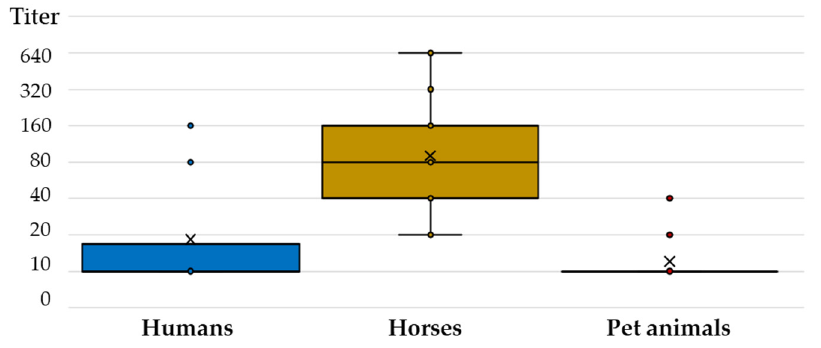
Figure 3. Geographic distribution of Tahyna virus seropositive humans, horses, and pet animals. (symbol size represents the number of cases) Comparing the TAHV NT antibody titers, a substantially higher titer was observed in horses (median 80, IQR = 40–160) compared to humans (median 10, IQR = 10–40) and pet animals (median 10, IQR = 10–10) (Figure 4).